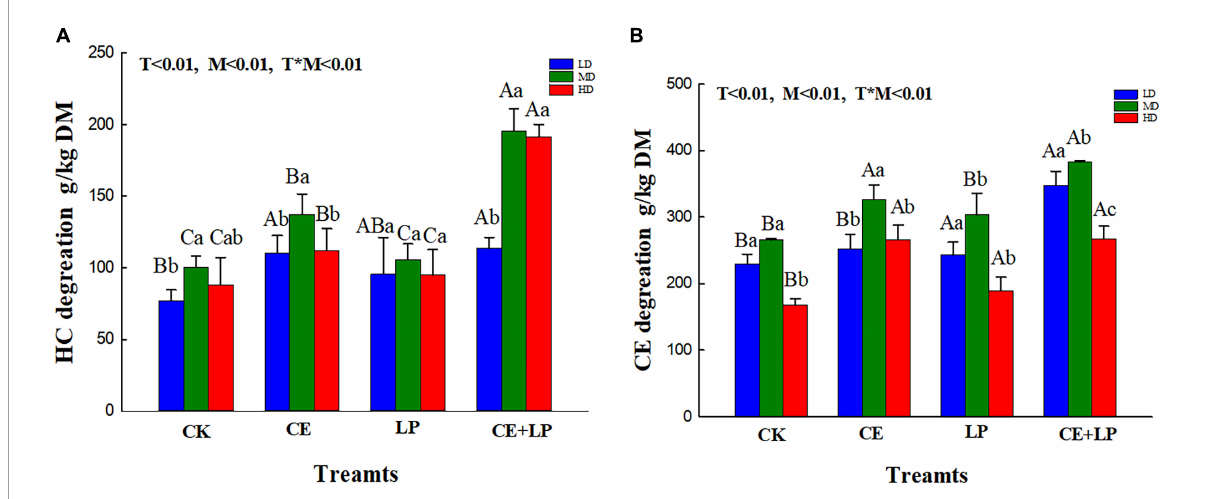
FIGURE1 Effects of additives and the moisture content on the hemicellulose degradation rate (A) and cellulose degradation rate (B) in the oats at 60 days of silage. CK, control; LP, L. plantarum ; CE, cellulase; LP+CE, combination of L. plantarum and cellulase. Different lowercase letters show significant differences among the same additive treatments in the different moisture contents ( P < 0.05). Different capital letters indicate the same significant differences among moisture contents in the different additive-treated groups ( P < 0.05). DM, dry matter; TN, total nitrogen; LD, the moisture content is approximately 67%; MD, the moisture content is approximately 75%; HD, the moisture content is approximately 81%; SEM, standard error of means; T, additive; M, moisture content; T × M, the interaction between the additive and moisture